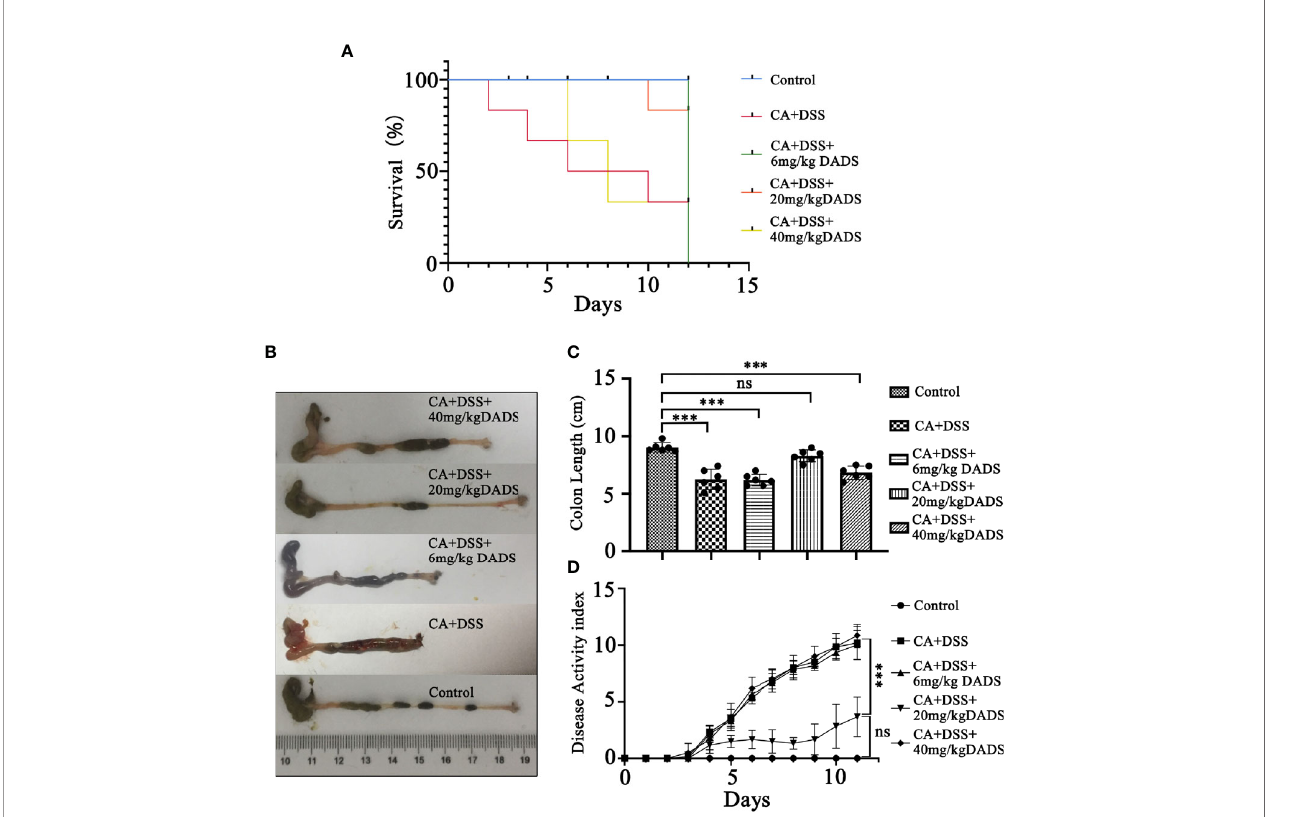
FIGURE 2 | Effects of different concentrations of DADS on mice with C. albicans infection. (A) Survival study. (B, C) Colon length and relevant statistical analysis. (D) The disease activity index of animals in each group. Data are presented as the mean ± SEM (n = 6). * P < 0.05, ** P < 0.01, *** P <